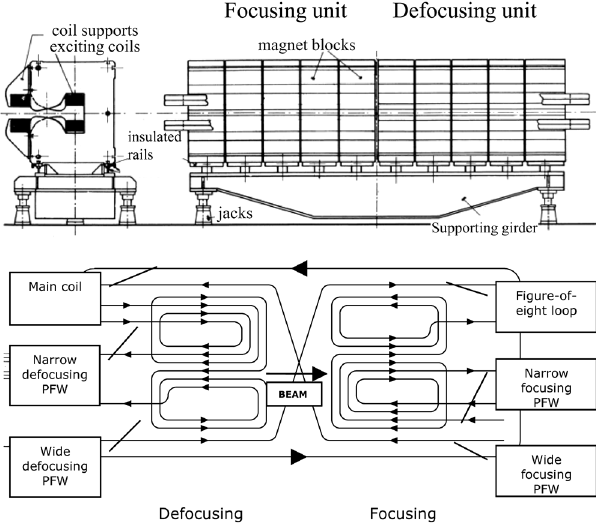
FIG. 2. Sketch of the PS main magnet (upper) and of the five circuits used to control tunes and chromaticities (lower), from [30].